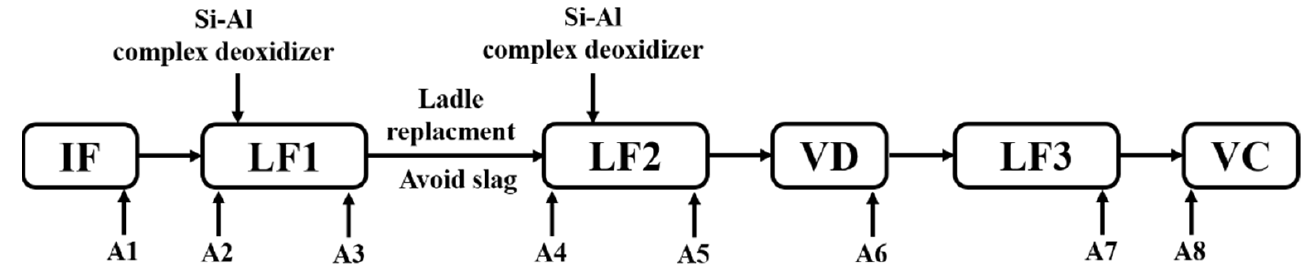
Figure 1. Schematic illustration of original metallurgical process and sampling.